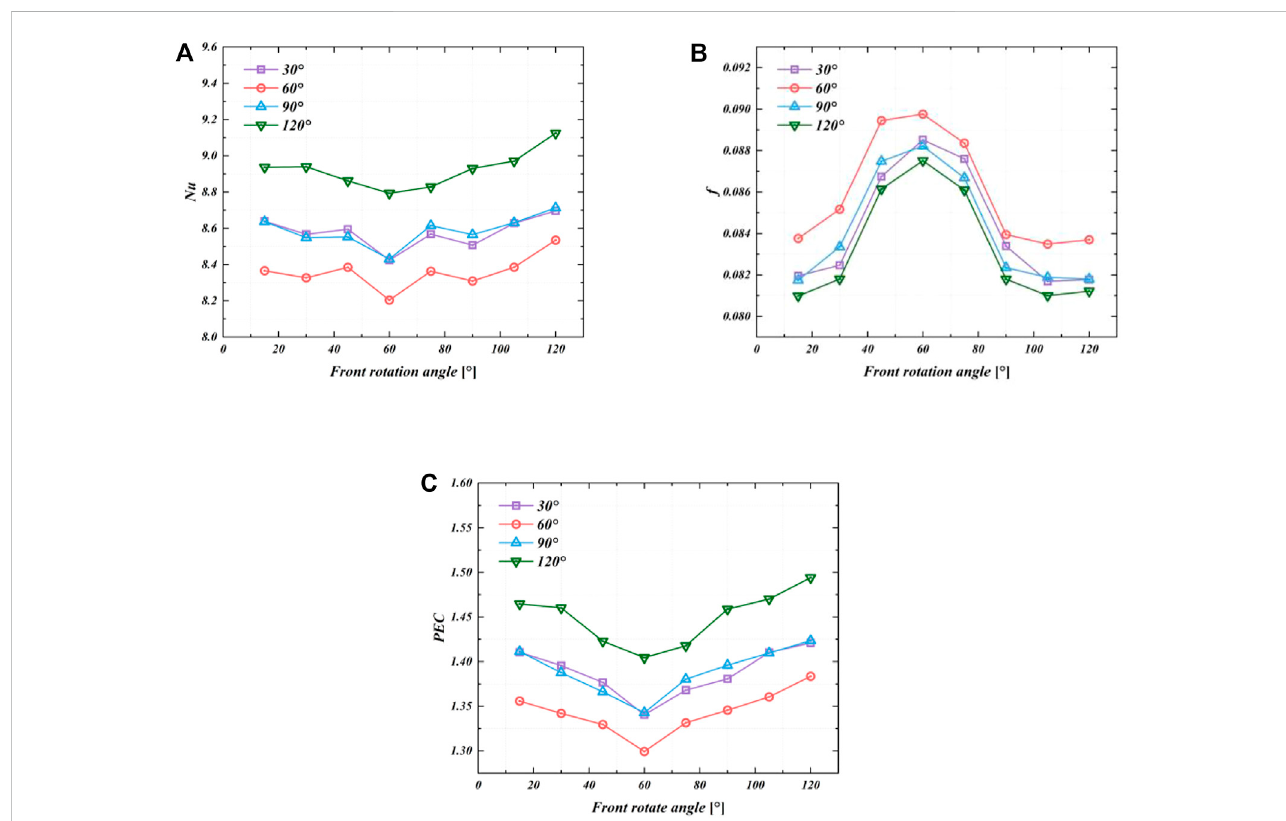
FIGURE 13 Effects of front rotation angle on cooling performance (Re = 663): (A) Nu; (B) f ; (C) PEC.